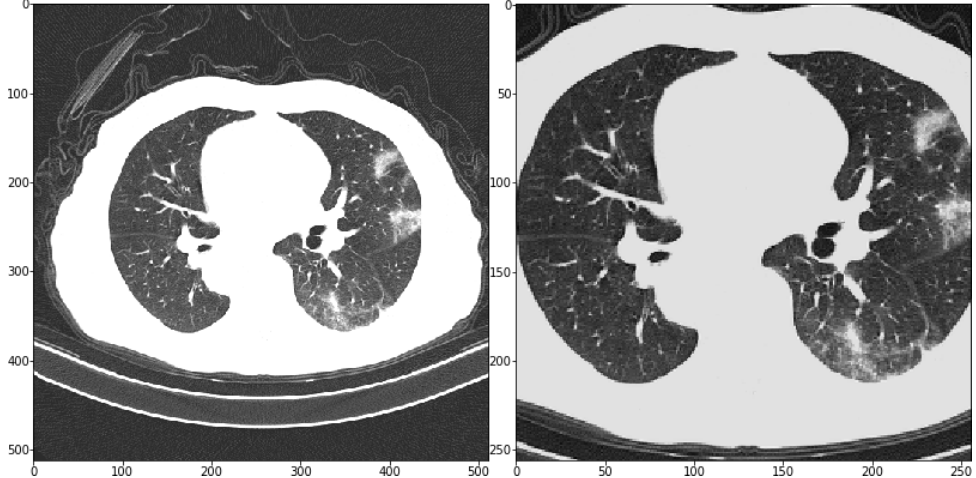
Figure 6. The left side shows an original chest CT slice of size 512 × 512. The right side shows the same chest CT slice after the pre-processing. The slice has been cropped in the center and then scaled to 256 × 256